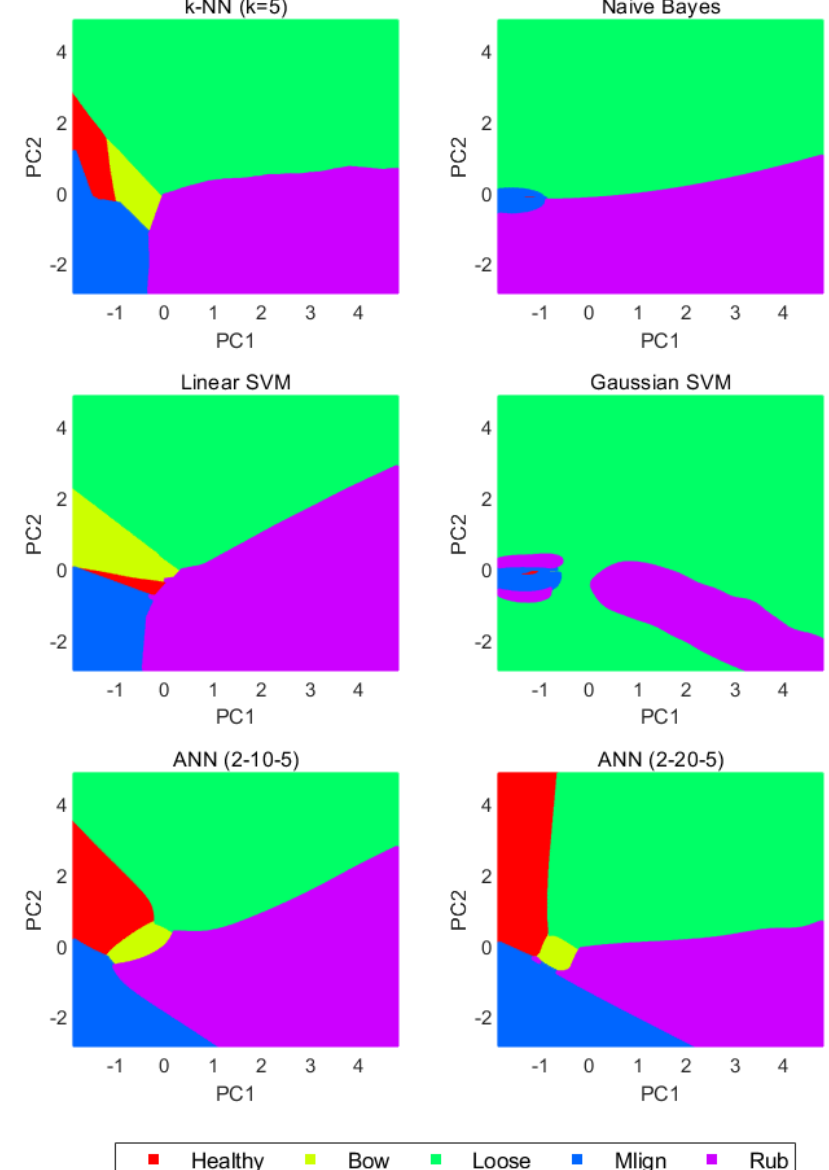
Figure 8. Visualised decision rules for the standardised ratio at 30 Hz.